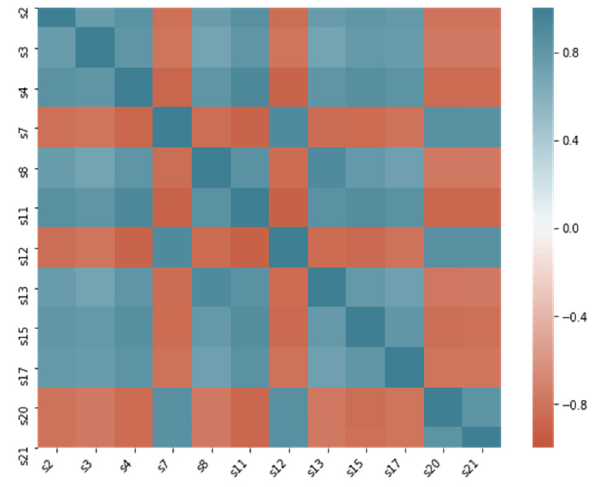
Figure 5. Correlation plot of variables (sensor2, sensor3, and sensor4) of FD001.